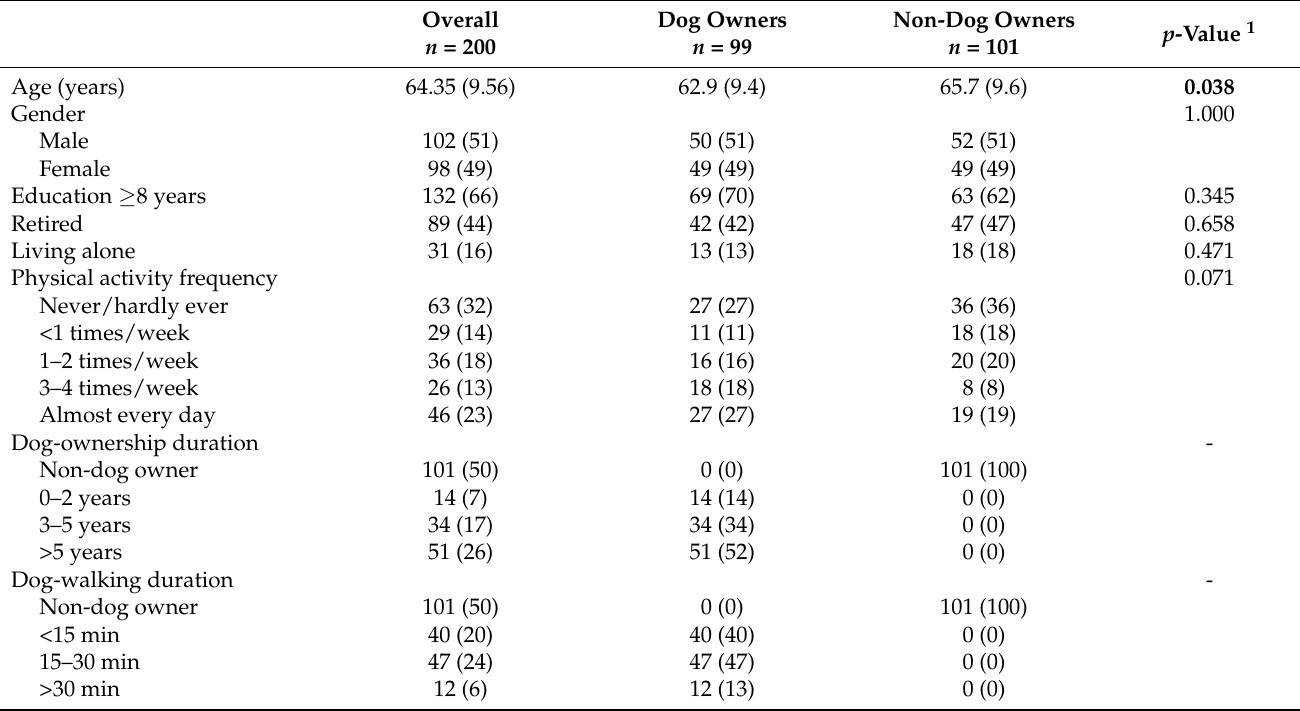
Table 1. Participant characteristics by dog-ownership.